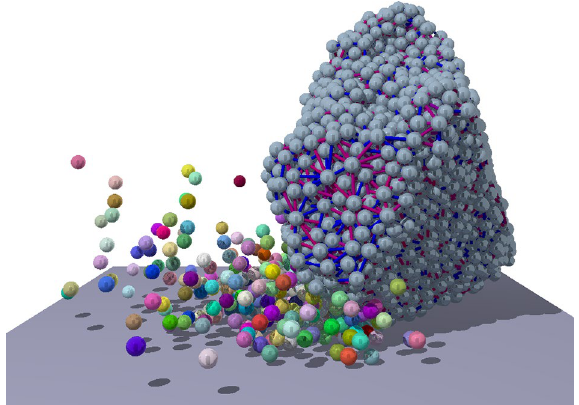
Figure 3. A snapshot of the 8th impact of a residue at the velocity v 0 / v f ≈ 0.4 using the same representation of fragments and cohesive contacts as in Fig. 1. The original edges have been already rounded due to mass